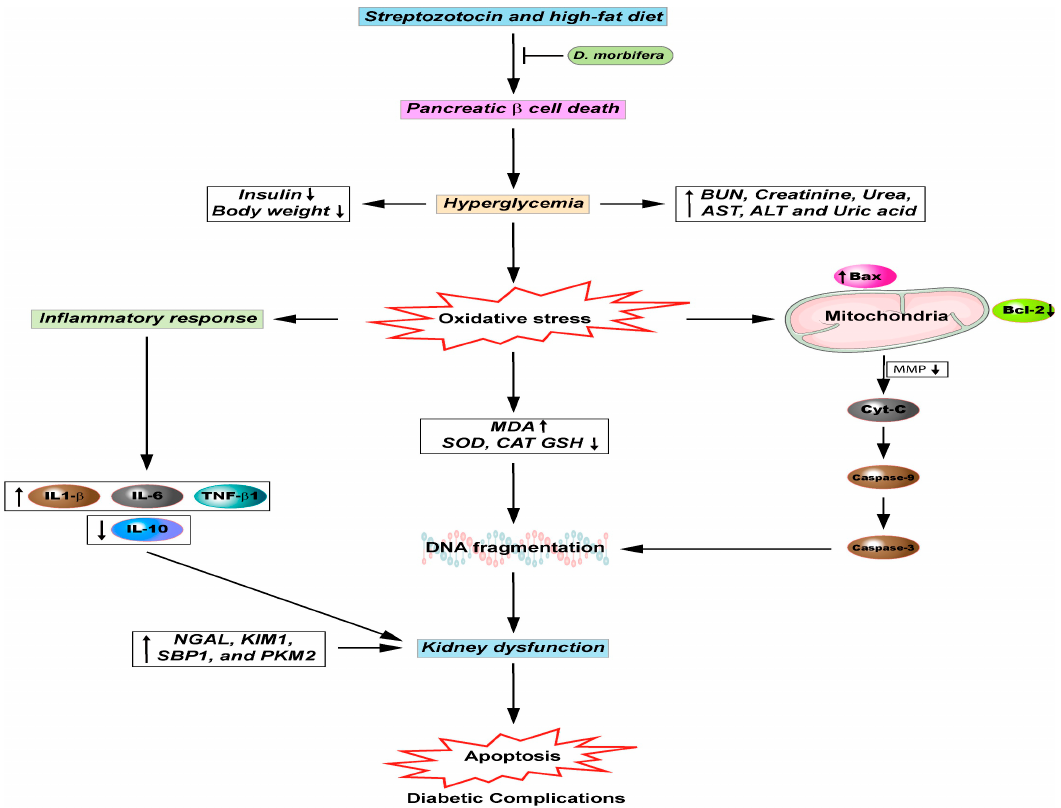
Figure 5. Anti-diabetic effect on D. morbifera . Bcl2: B-cell lymphoma 2; MMP: Mitochondrial membrane potential; Cyt-C: Cytochrome-C; IL-1 β : Interleukin 1 beta; IL-10: Interleukin 10; IL-6: Interleukin 6; TGF- β 1: Transforming growth factor beta 1; NGAL: KIM1: Kidney injury molecule-1; Neutrophil gelatinase-associated lipocalin; SBP1: Selenium binding protein-1; PKM2: Pyruvate kinase muscle isozyme M2; BUN: Blood urea nitrogen; ALT: Alanine amino transferase; AST: Aspartate amino transferase; MDA: Malondialdehyde; DNA: Deoxyribonucleic acid; CAT: Catalase; SOD: Superoxide dismutase; GSH: Reduced glutathione.